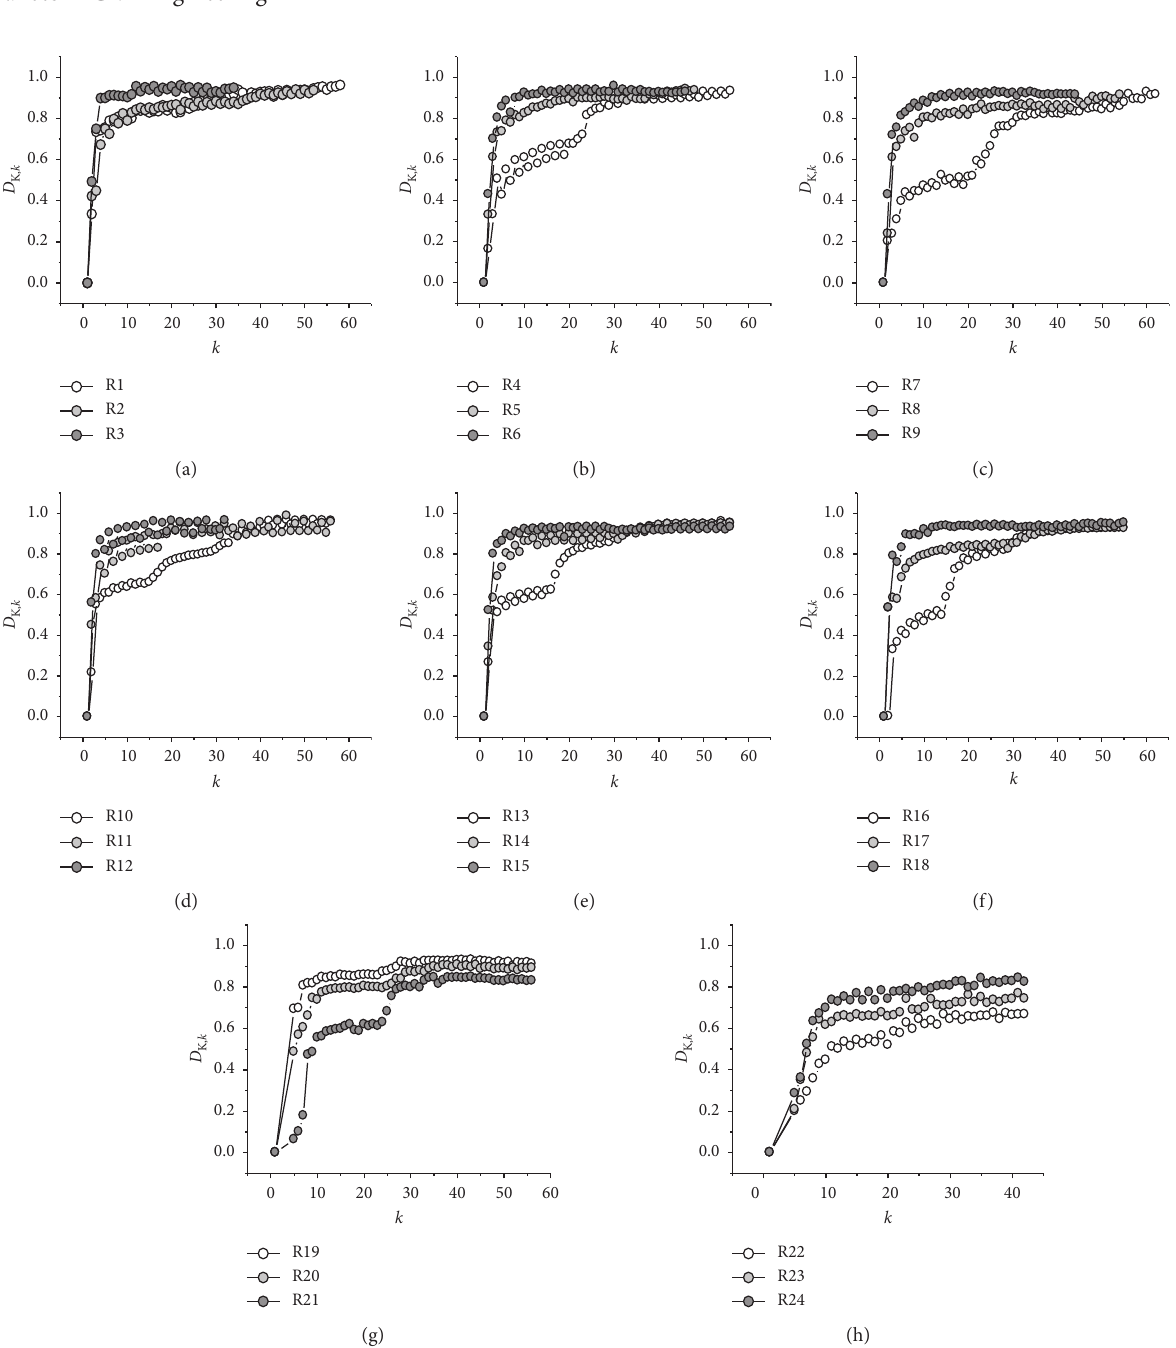
Figure 5: D K, k -k relations of specimens R1 to R24. (a) Group 1. (b) Group 2. (c) Group 3. (d) Group 4. (e) Group 5. (f) Group 6. (g) Group 7. (h) Group